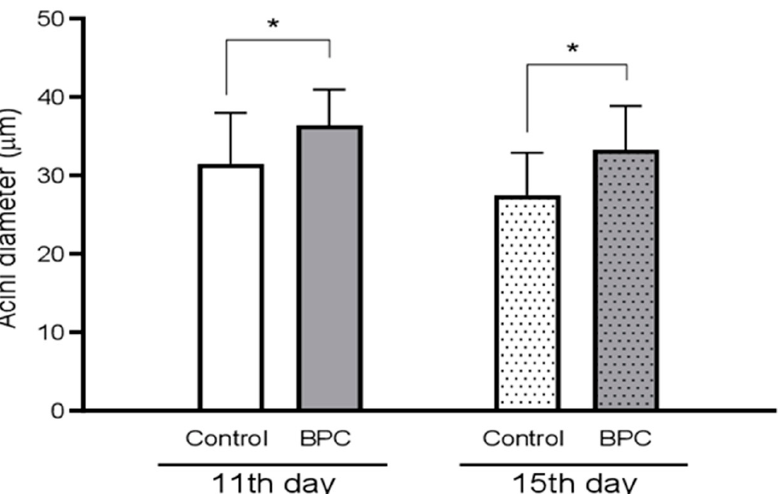
Figure 7. Acini diameter of hypopharyngeal glands dissected from 11- and 15-day-old honeybees, during experiments in laboratory–controlled conditions, for the experimental BPC and control groups. Asterisks indicate statistically significant differences comparing the mean acini diameters between the BPC and control groups, * p < 0.01, mean ± SD.